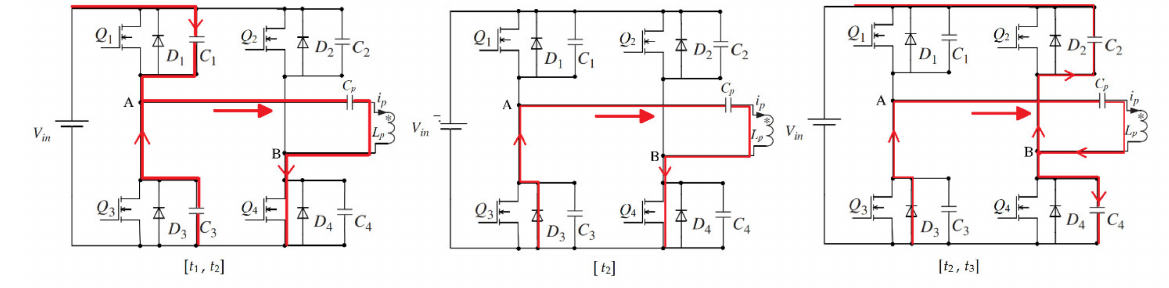
Figure 5. Equivalent circuits of different switching modes in hard-switching condition.